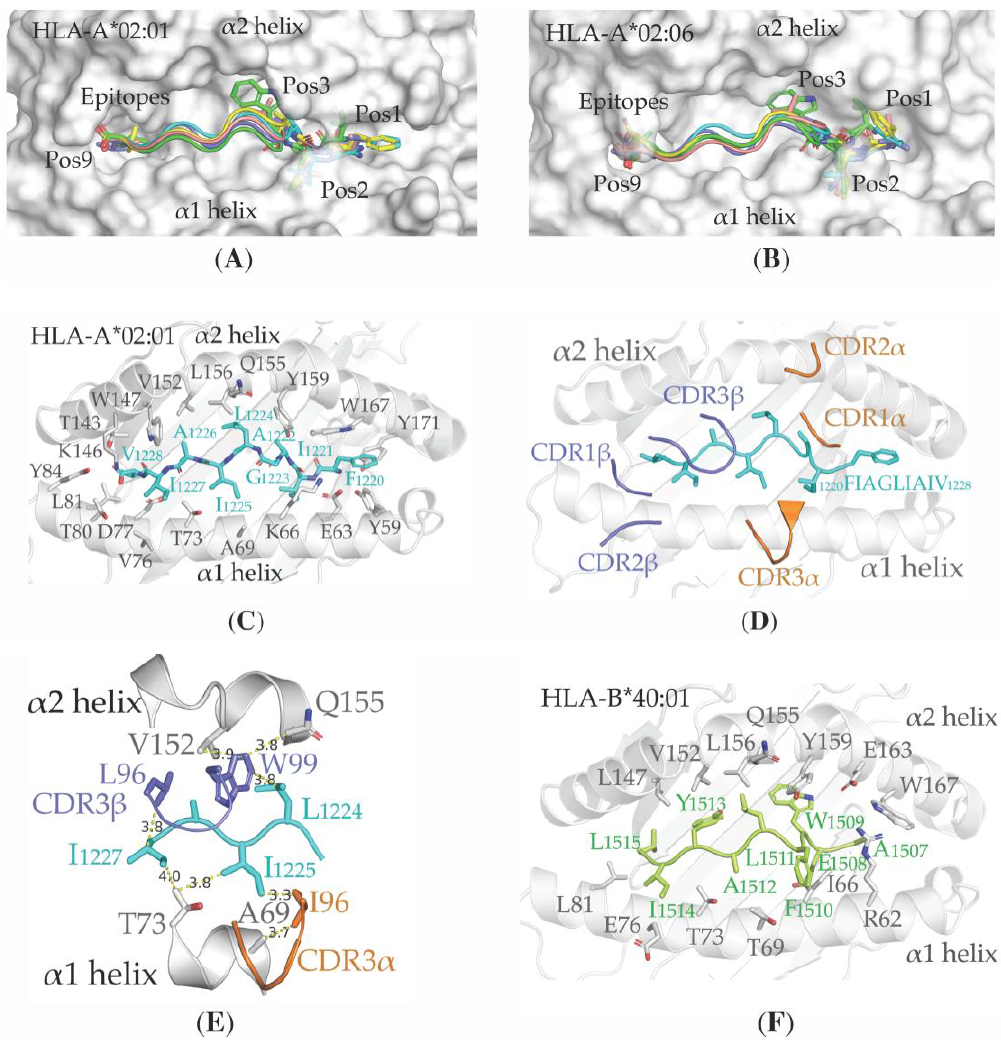
Figure 2. 3D structural models of MHC-I in complex with selected epitopes (Table 4) and ternary complex of MHC-I–epitope—T cell receptor (TCR). ( A ) and ( B ) Five immunogenic epitopes (Table 4) were docked into the cleft between the α 1 and α 2 helices of HLA-A*02:01 (PDB ID: 5TEZ, chain A) and HLA-A*02:06 (PDB ID: 3OXR, chain A) (surface presentation). The epitopes 1220 FIAGLIAIV 1228 , 17 VLLFLAFVV 25 , 20 FLAFVVFLL 28 , 204 VLAWLYAAV 212 and 184 VLWAHGFEL 192 are respectively colored cyan, yellow, blue, salmon and green, and are shown as ribbons; residues at Pos1-3 and Pos9 as sticks; ( C ) Structure of the epitope 1220 FIAGLIAIV 1228 (cyan sticks) docked into the cleft of HLA-A*02:01 (PDB ID: 5TEZ, chain A; gray cartoon and sticks). Residues G1223 to I1227 of the epitope and A69, K66, V76, T80, K146, V152 and Q155 of HLA-A*02:01 have solvent-exposed side chains; ( D ) Ternary complex structure of HLA-A*02:01 (gray cartoon), epitope 1220 FIAGLIAIV 1228 (cyan loop and sticks) and TCR. Conformations of the CDR1 α , CDR2 α and CDR3 α loops of the TCR- α chain (orange) and CDR1 β , CDR2 β and CDR3 β of the TCR- β chain (blue) are shown; ( E ) Side chains of residues of CDR3 α (orange sticks) and CDR3 β (blue sticks) loops making hydrophobic interactions (dotted yellow line; distances in Ångströms) with both the epitope 1220 FIAGLIAIV 1228 (cyan sticks) and the HLA-A*02:01 molecule (residues located at the α 1 and α 2 helices; gray sticks) are shown; ( F ) Structure of the epitope 1507 AEWFLAYIL 1515 (green loop and sticks) docked into the cleft of HLA-B*40:01 (PDB ID: 6IEX, chain A; gray cartoon and sticks). Table 6. Comparison of the Cα atom positions of the five most immunogenic SARS-CoV-2 epitopes. Upper and lower triangular data show root–mean–square deviations in Å ngströms for the epitopes in complex with HLA-A*02:01 and HLA-A*02:06, respectively.